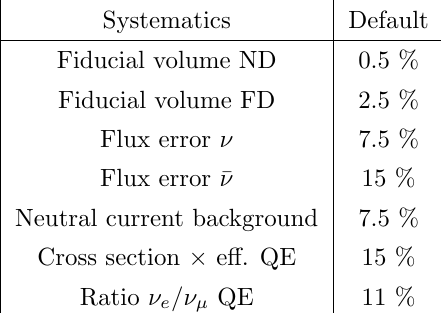
Table 1 . Systematic uncertainties for a super beam as described in ref. [30] for the \Default"